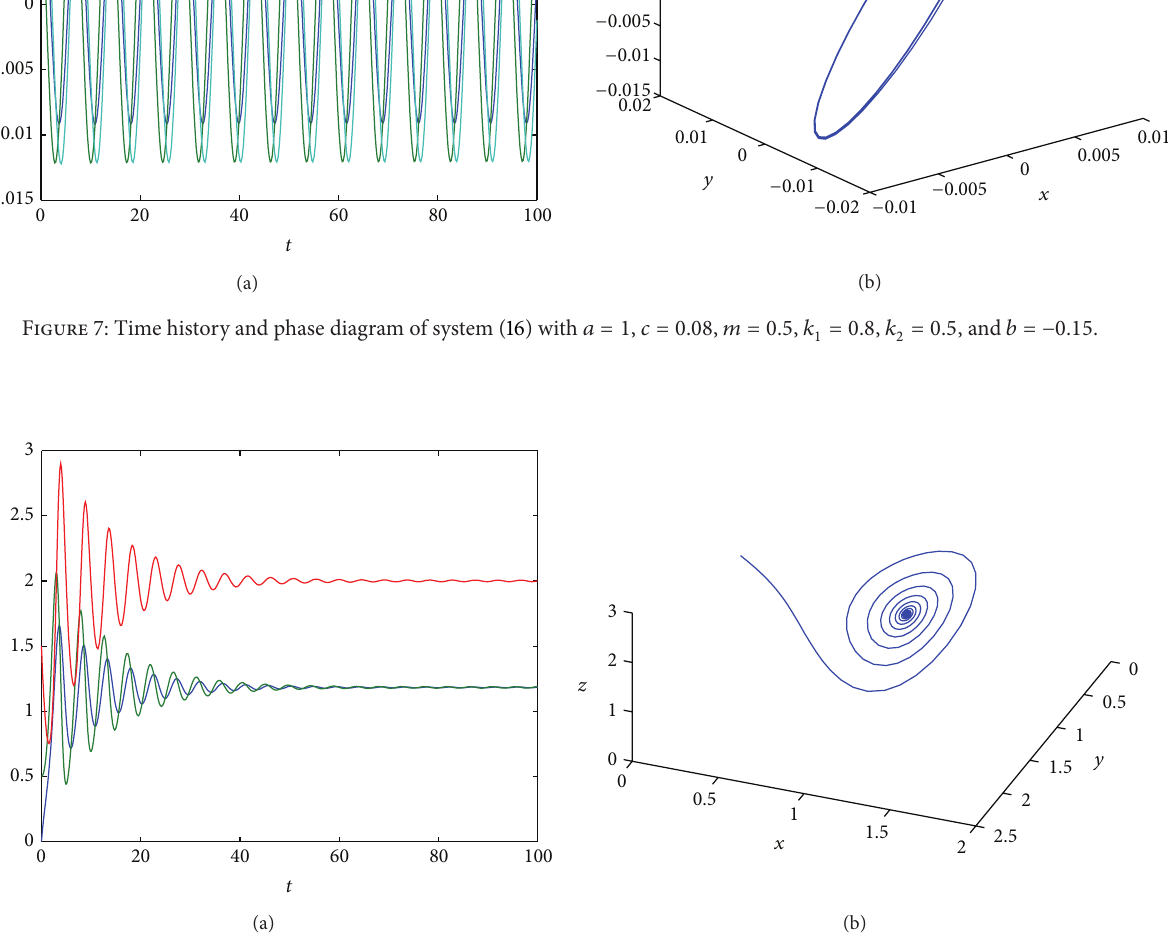
Figure 8: Time history and phase diagram of system (1) with 𝑎 = 1 , 𝑏 = 2 , and 𝑐 = 0.6998